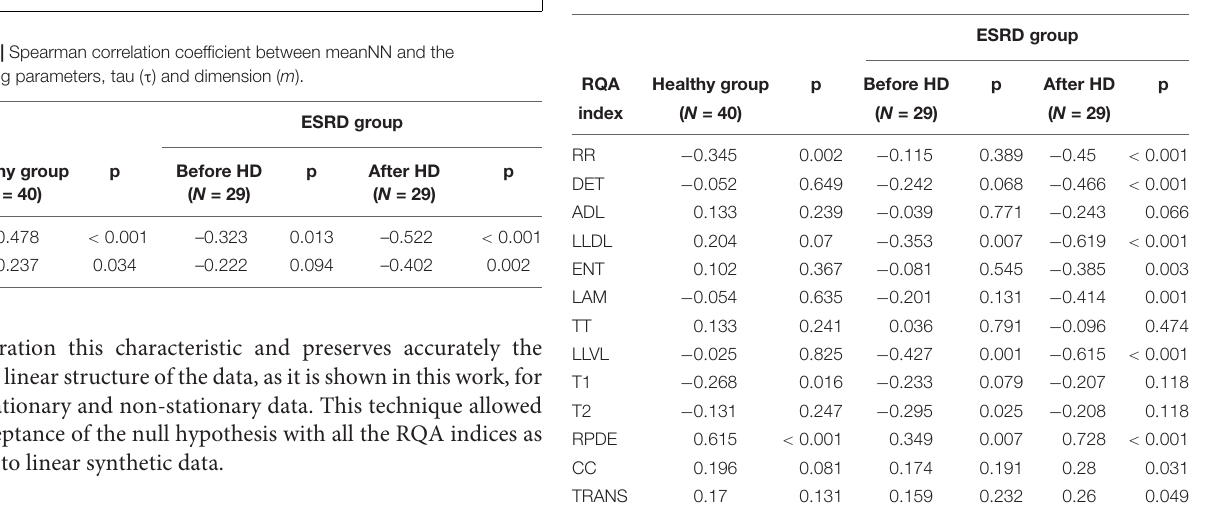
TABLE 5 | Spearman correlation coefficients between meanNN and recurrence quantitative analysis (RQA) indices for Iterative Amplitude Adjusted Fourier Transform (IAAFT) surrogates of heart rate variability (HRV) time